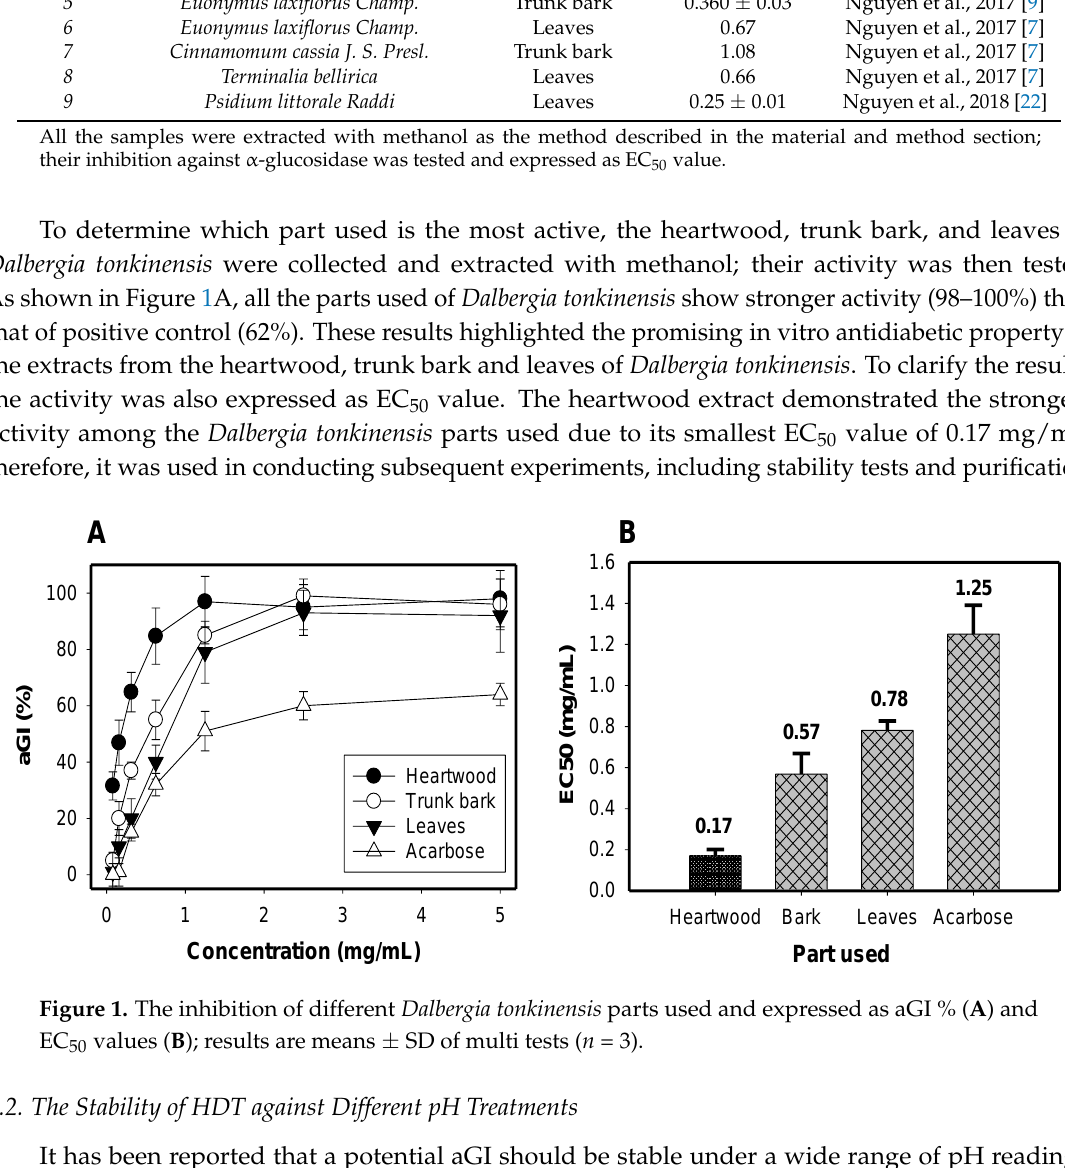
Table 1. α -glucosidase inhibition of some potential extract of medicinal plants collected in Dak Lak.